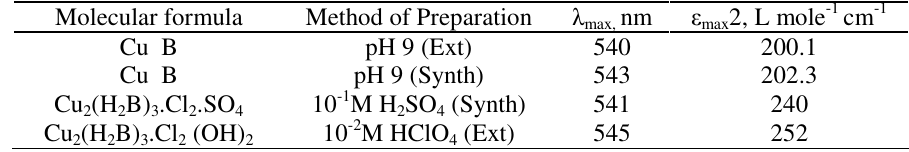
Table 3. Visible spectra of some of Cu-BHPDE complexes in chloroform Molecular formula Method of